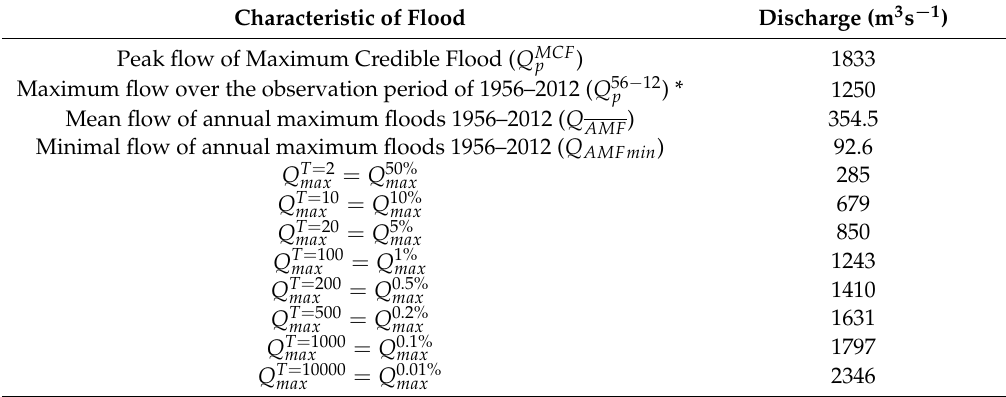
Table 1. Values of peak flow of Maximum Credible Flood, maximum flow over the monitoring period (1956–2012), mean and minimum flow of annual maximum floods, and maximum floods with a T -year return period in years for the Zywiec post on the Sola River.